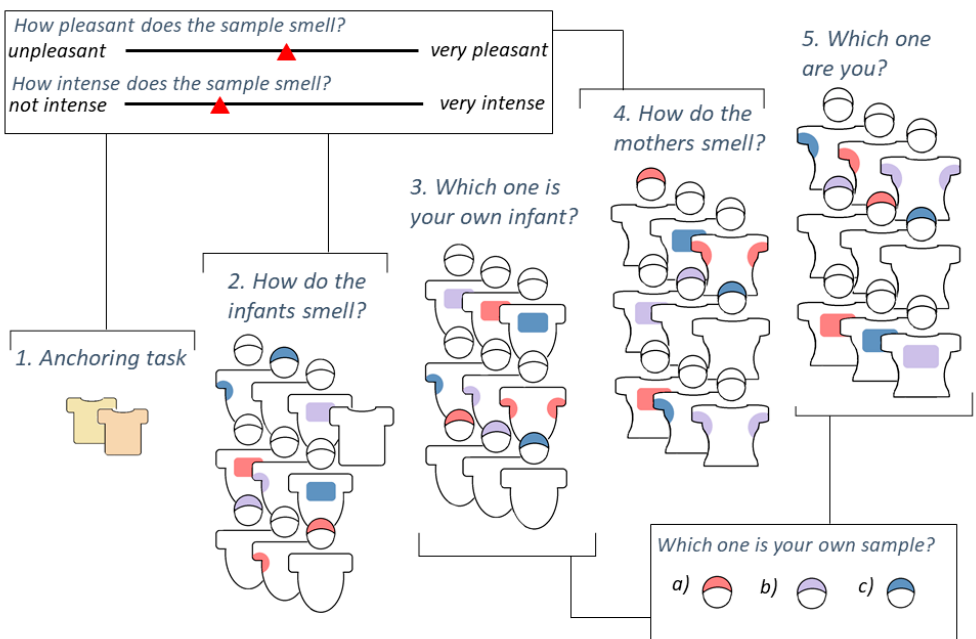
Figure 1. Visualisation of experimental procedure. Anchoring task (1.): smelling 2 unrelated child odours; (2.) Rating of infantile odours on three body sites (axilla, breast, head) plus blank control sample by pleasantness and intensity, randomised order of samples; (3.) Identification of own child for each body site, randomised order of body sites and samples; (4.) Rating of maternal odours on three body sites (axilla, breast, head) by pleasantness and intensity, randomised order of samples; (5.) Identification of own body odour for each body site, randomised order of body sites and samples.